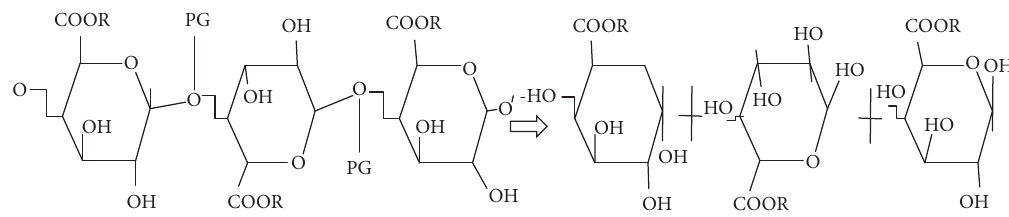
Figure 3: The action of polygalacturonases on polygalacturonic acid chain